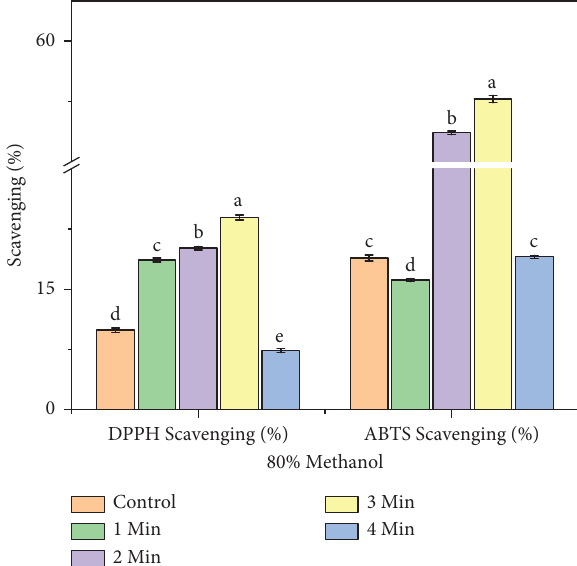
Figure 22: Estimation of ABTS/DPPH scavenging in radish seedlings. Figure 23: Estimation of DPPH/ABTS in carrot seedlings.